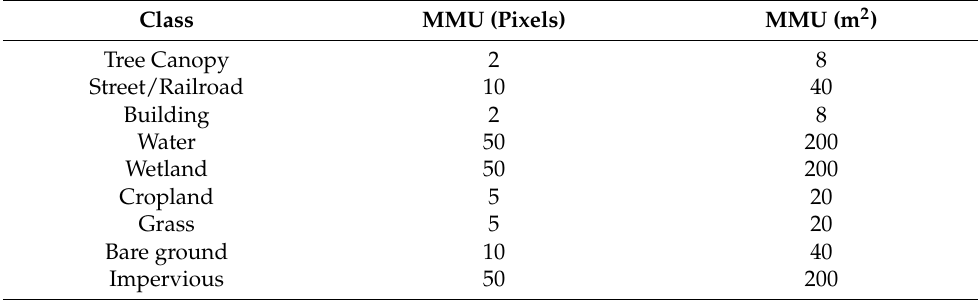
Table 1. Minimum mapping unit (MMU) for different land cover classes. Class MMU (Pixels) MMU (m 2 ) Tree